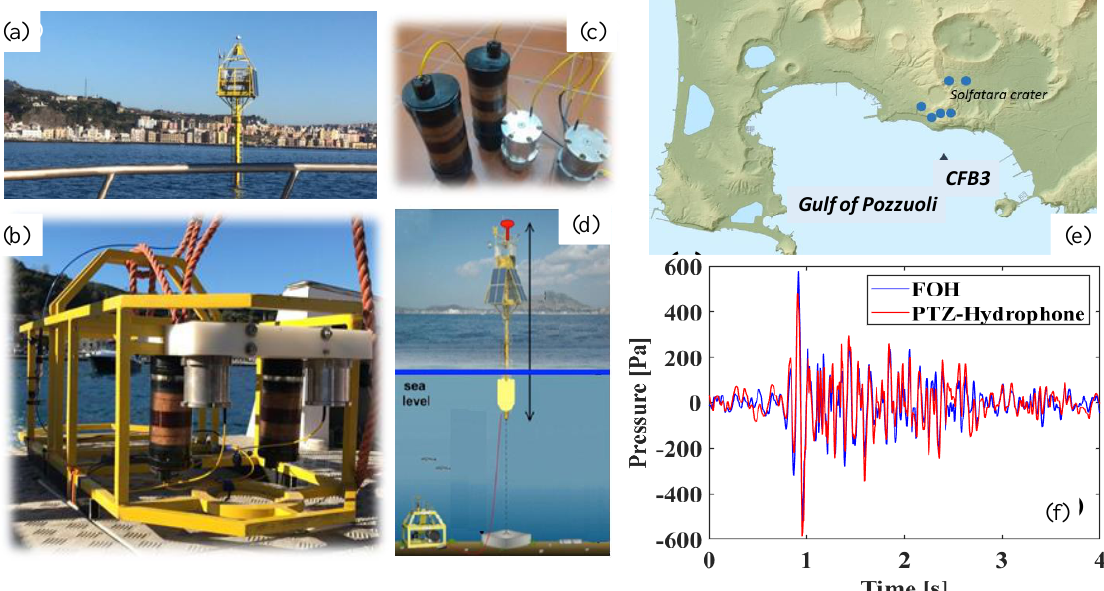
Figure 17. ( a ) Geodetic buoy of the INGV seismic monitoring network ( b ) Submarine module equipped with FOH sensors ( c ) Two FOHs (at left) and two dummy hydrophones (at right) ( d ) Sensing system installation scheme ( e ) Geographical Map of the Campi Flegrei caldera region. CFB3 is the buoy. Blue dots represent the epicenters of the main detected earthquakes ( f ) FOH (blue line) and PZT (red line) time response associated to one of the detected earthquakes (Reproduced with permission from ref [71], the figure is released under a Copyright Clearance Center’s RightsLink ®